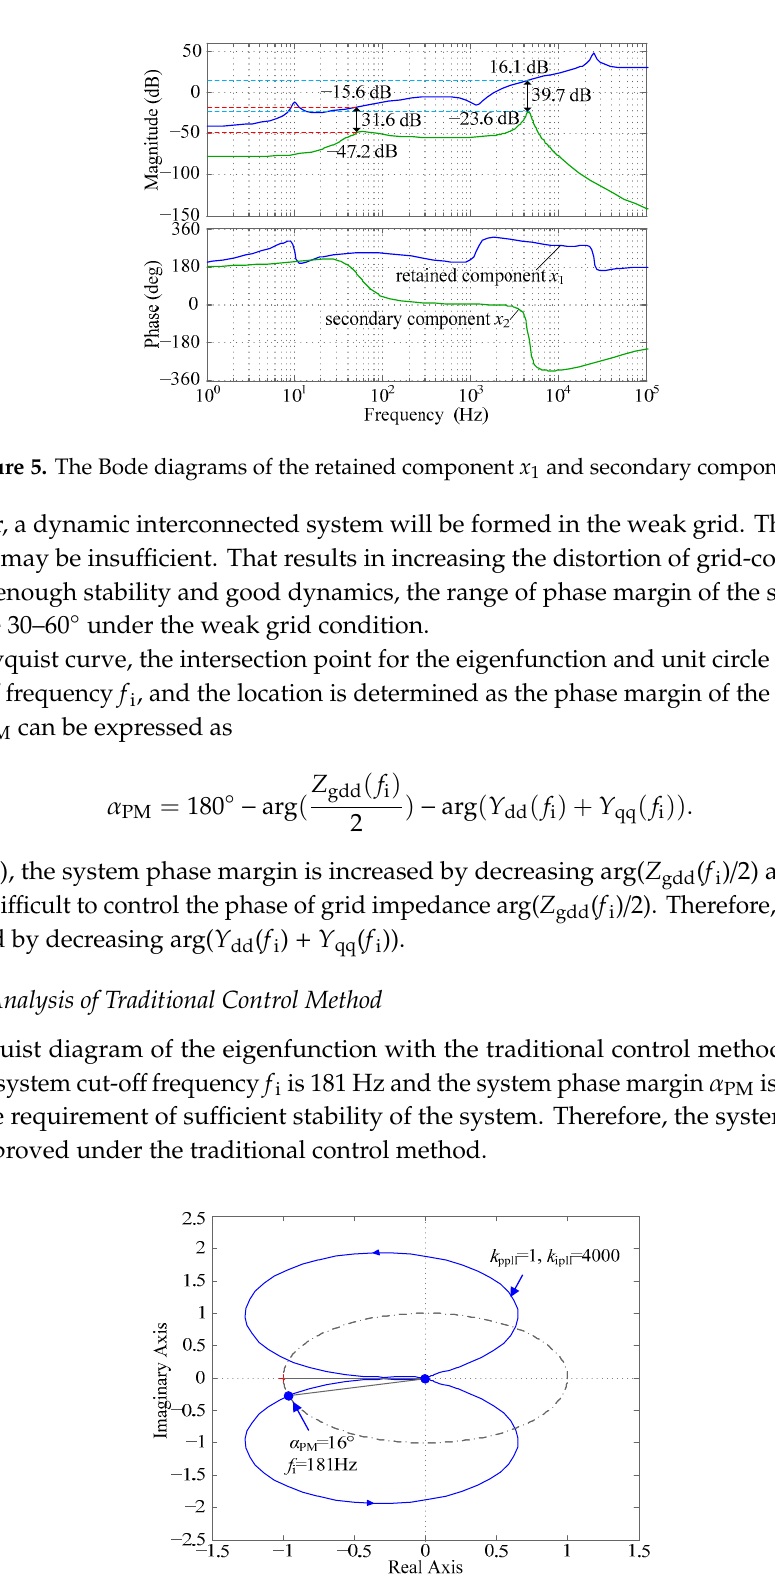
Figure 6. The Nyquist diagram of the eigenfunction with the traditional control method.